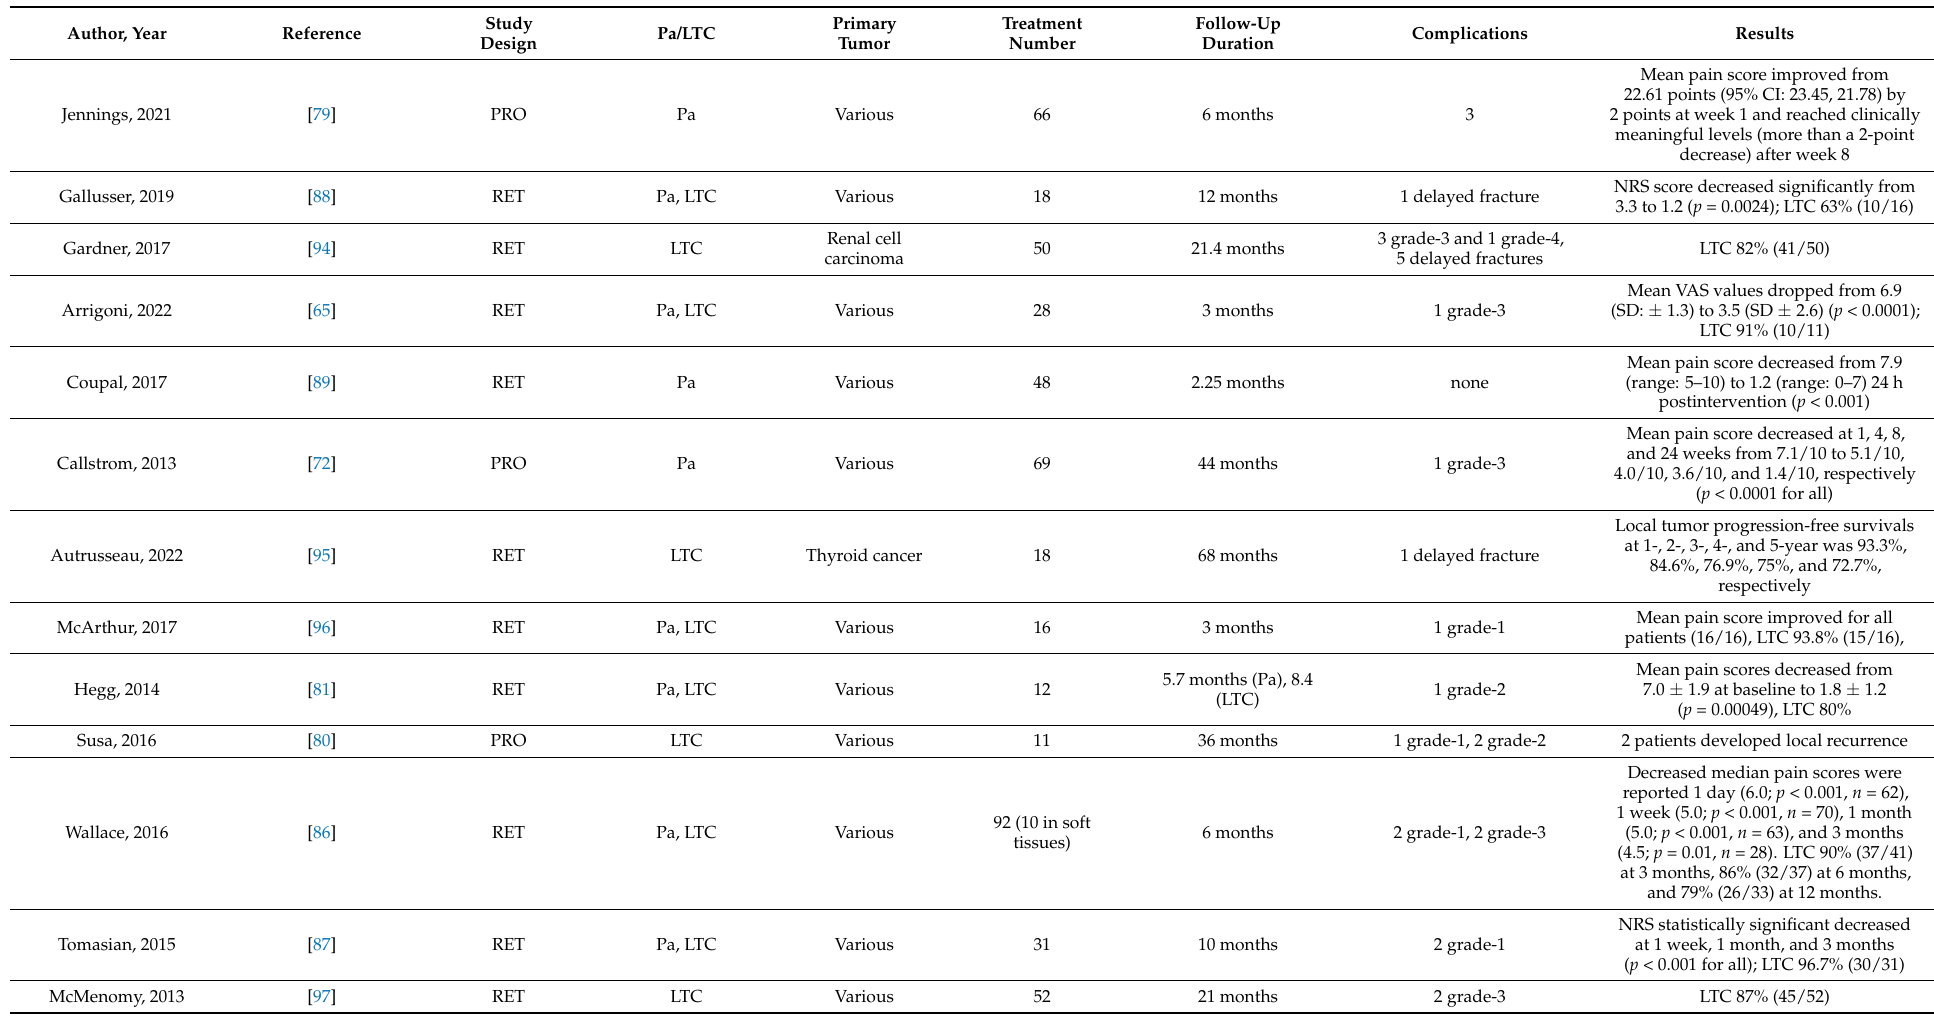
Table 2. Studies evaluating the role of cryoablation in the management of bone